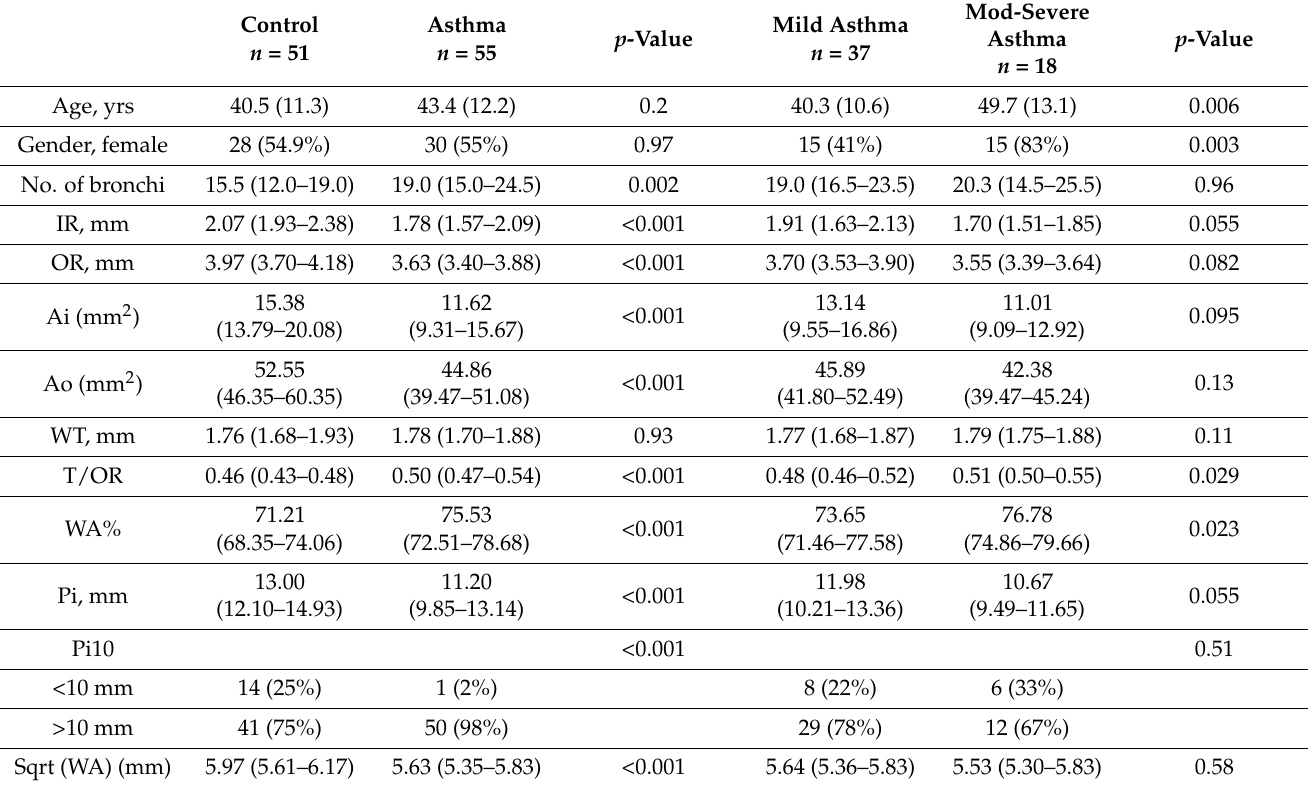
Table 2. Computed tomography (CT) metrics in asthma and heathy